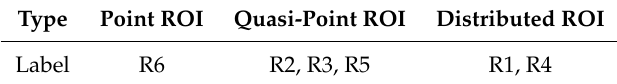
Table 3. Description of test